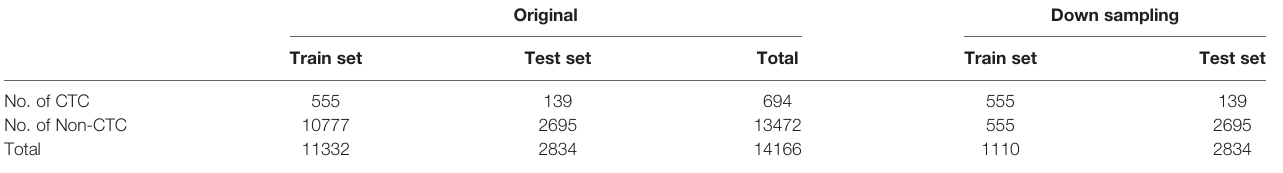
TABLE 2 | The number of